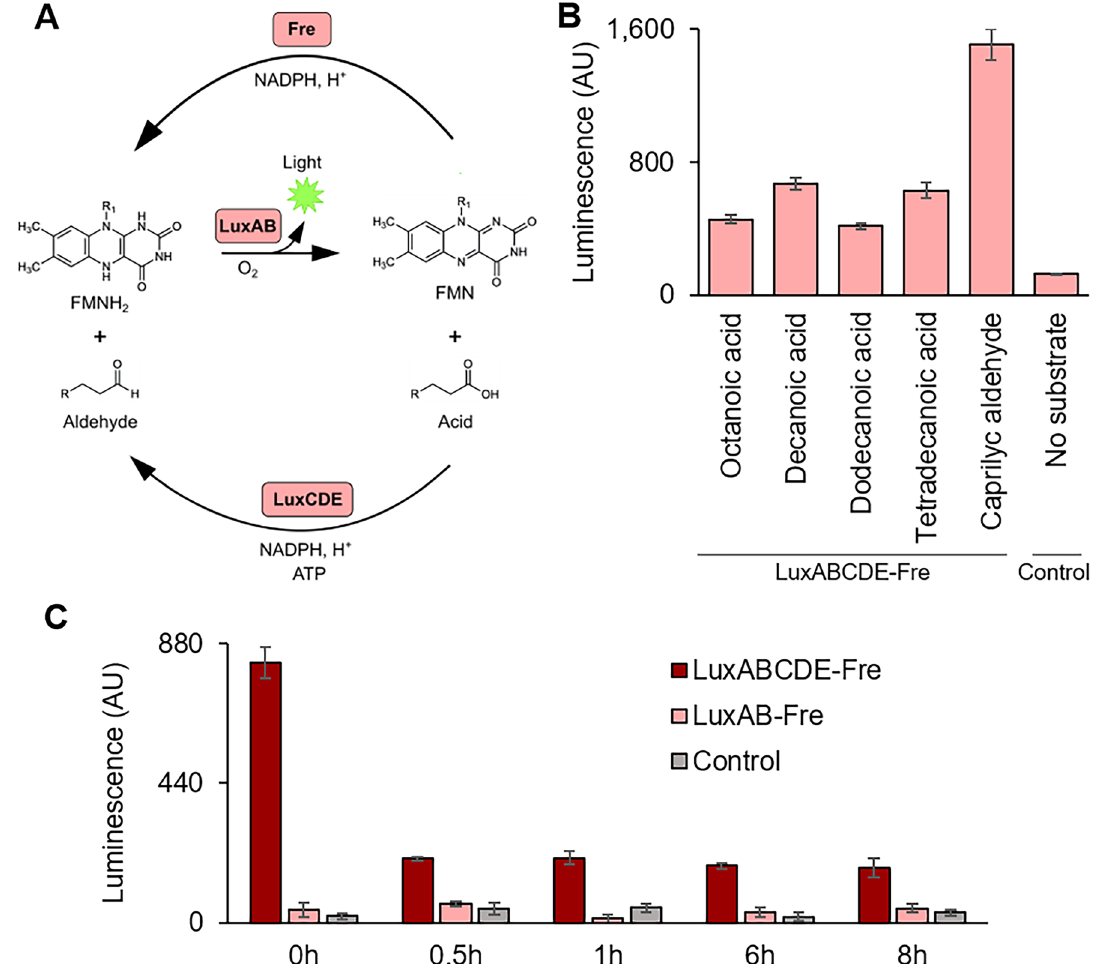
Figure 3. Substrate regeneration system with LuxABCDE-Fre. ( A ) The schematic of the LuxABCDE-Fre substrate regeneration system. LuxAB generates light with reduced flavin mononucleotide (FMNH 2 ) and long- chain aldehyde; those substrates are converted into oxidized flavin mononucleotide (FMN) and corresponding long-chain acid. NAD(P)H-flavin reductase (Fre) reduces FMN back to FMNH 2 , and LuxCDE reduces the acid back to the corresponding aldehyde. ( B ) Luminescence measurement with the LuxABCDE-Fre system. LuxAB- Fre and LuxCDE were expressed in TXTL and mixed with 1 mM long-chain fatty acids (octanoic acid, decanoic acid, dodecanoic acid, or tetradecanoic acid) or caprylic aldehyde, followed by luminescence measurement. The reaction also contained FMN, NADPH, and ATP. Control represents a reaction using TXTL without enzyme expression. ( C ) Luminescence kinetics measurement with decanoic acid. LuxAB-Fre and LuxCDE were expressed in TXTL. For LuxABCDE-Fre reaction, the TXTL expressing LuxAB-Fre and LuxCDE were mixed with 1 mM decanoic acid (time = 0). For LuxAB-Fre reaction, the TXTL expressing LuxAB-Fre was used. For Control reaction, TXTL without enzyme expression was used. The reaction also contained FMN, NADPH, and ATP. The luminescence was measured after 0.5, 1, 6, and 8 h. The graphs show means with error bars that signify SEM (n =